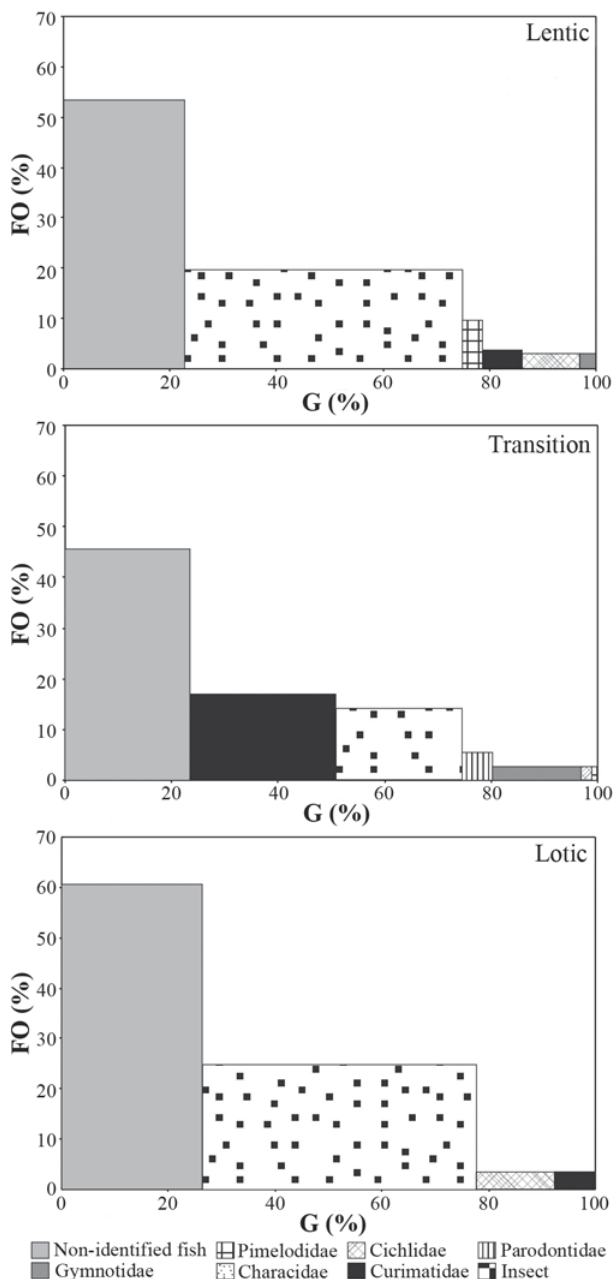
Fig. 5. Categories of food items observed in A. pantaneiro according to the frequency of occurrence (FO%) and gravimetric (G%) methods in different hydrological conditions. The number of analyzed stomachs is 228 in lentic sites, 73 in transition and 52 in the lotic sites.